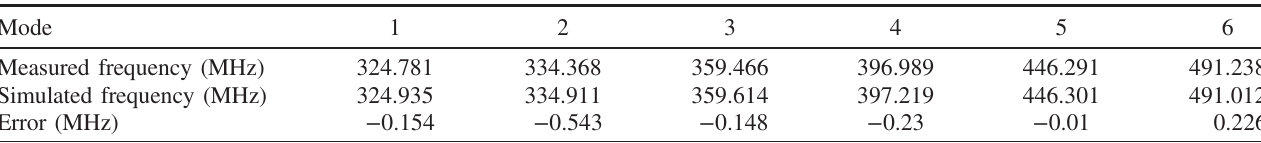
TABLE II. Measured and simulated frequencies of modes inside the IH-DTL cavity. Mode